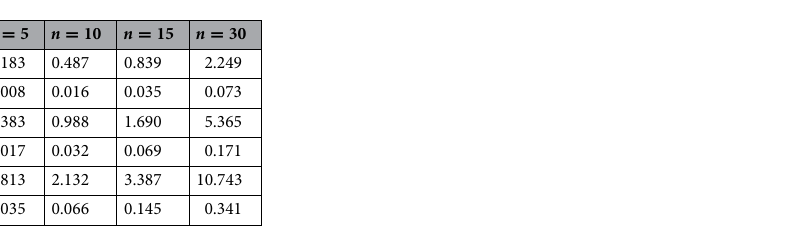
Table 1. Average computational time (in s) to compute Fréchet mean of N correlation matrices of size ( n × n ) under correlation and SPD